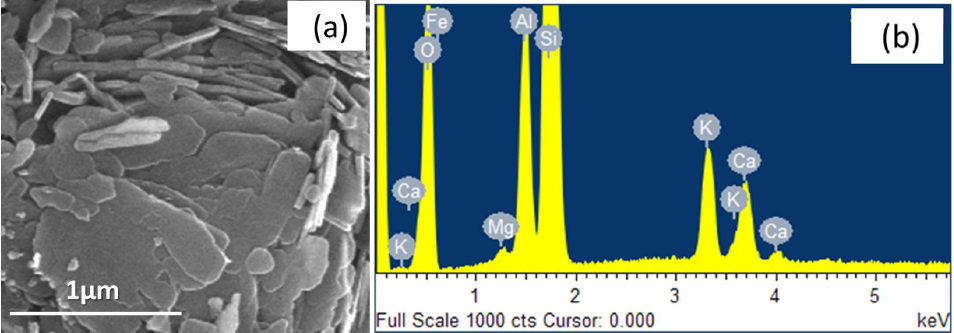
Figure 2. SEM-micrograph of the clinoptilolite single lamellar crystals generated by sample delamination ( a ) and EDS spectrum of the geomorphic clinoptilolite surface ( b ).